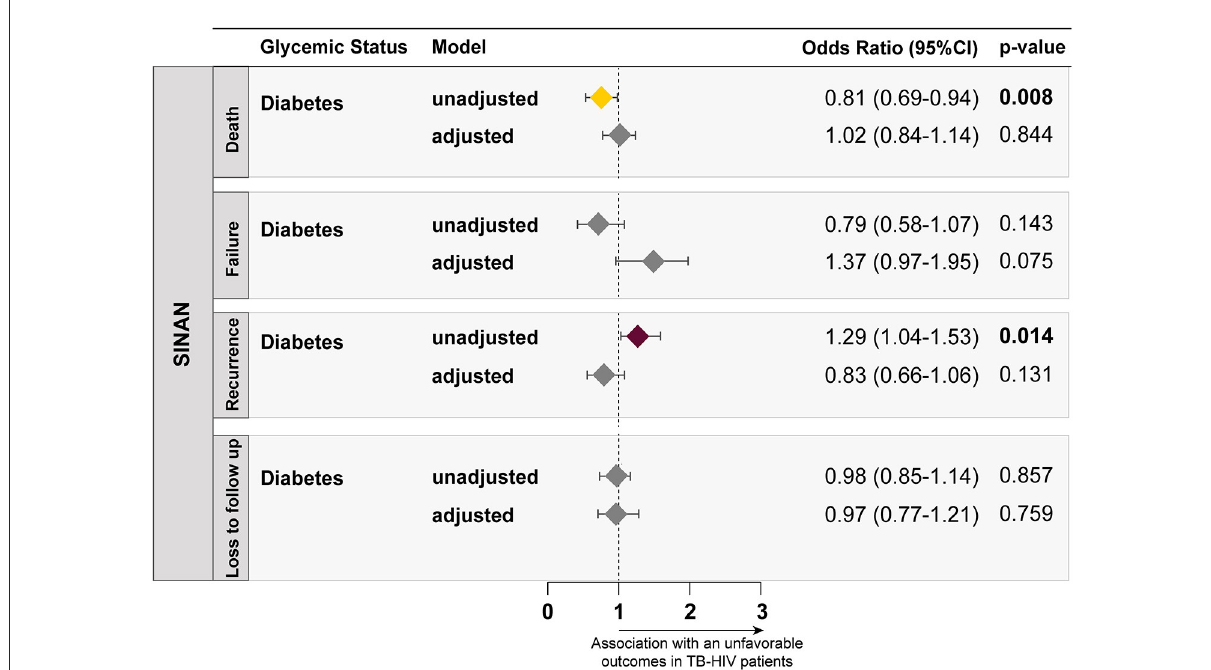
FIGURE3 Four multivariable logistic regression models, utilizing the ENTER method, testing associations between the presence of DM (reference: no DM) and different subcategories of unfavorable outcomes, including death (reference: clinical or bacteriological cure), treatment failure (reference: clinical or bacteriological cure), TB recurrence (reference: clinical or bacteriological cure) and loss to follow up (reference: clinical or bacteriological cure), were performed and plotted. All the variables included in the models can be found on Supplementary Table